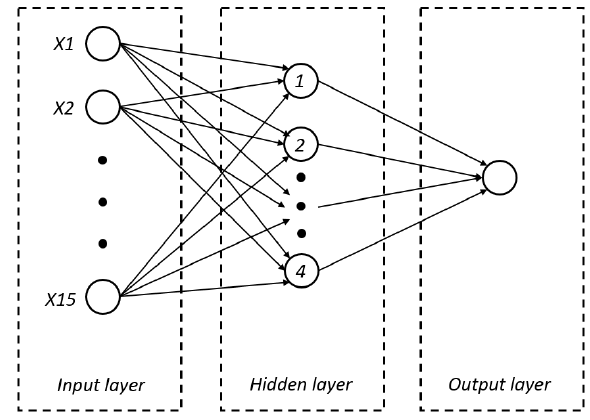
Figure 2: The best performing topological structure (architecture) of the Multilayer Perceptron used in numerical example.